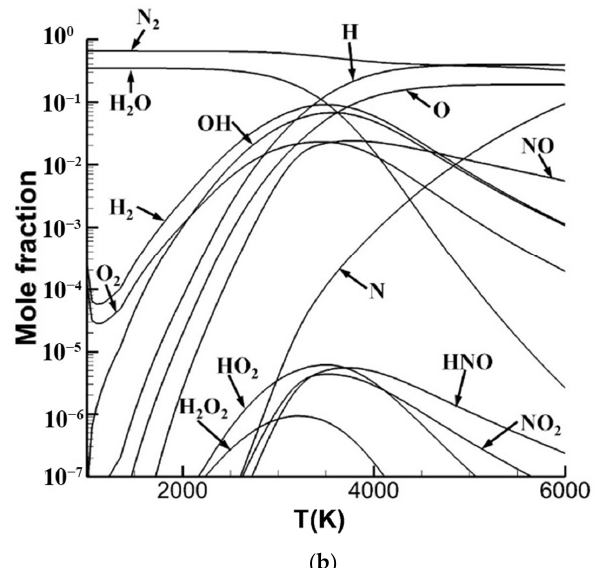
Figure 3. Mole fraction of products after steady-state combustion. ( a ) 1 atm. ( b ) 2 atm. To ensure the reasonableness of the neglection of the trace species in the steady-state combustion, which might be the active species to influence the combustion, unsteady- state combustion under the specific temperature of 1000 K and 2000 K is also performed, where the evolution of the mole fraction of species is shown in Figure 4. The mole fraction of H 2 O 2 and HO 2 is less than 10 −4 , and the mole fraction of HNO and NO 2 is less than 10 −8 , which is consistent with the result of the steady-state combustion, where the effect on the ignition and combustion is negligible. In addition, the increment of trace species is after the ignition illustrated by the peak mole fraction of OH, which further indicates the rea- sonableness of the neglection.